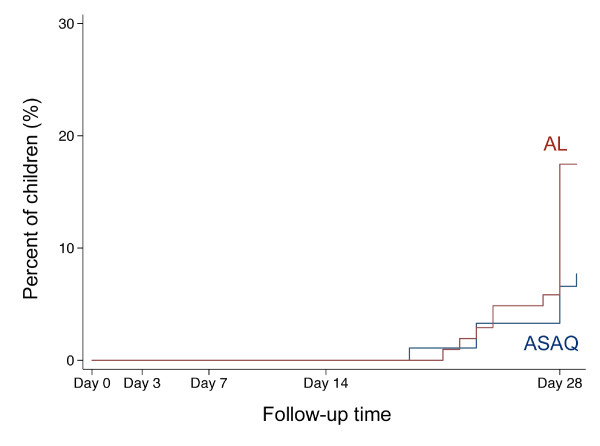
Kaplan-Meier failure curve of late clinical failures (LCF). The figure shows the percentage of children with LCF during the follow-up time of 28 days (in some plus 1 day) separated by treatment group according to the per-protocol analysis. The red line indicates children treated with artemether-lumefantrine (AL), the blue line indicates children treated with artesunate plus amodiaquine (ASAQ).